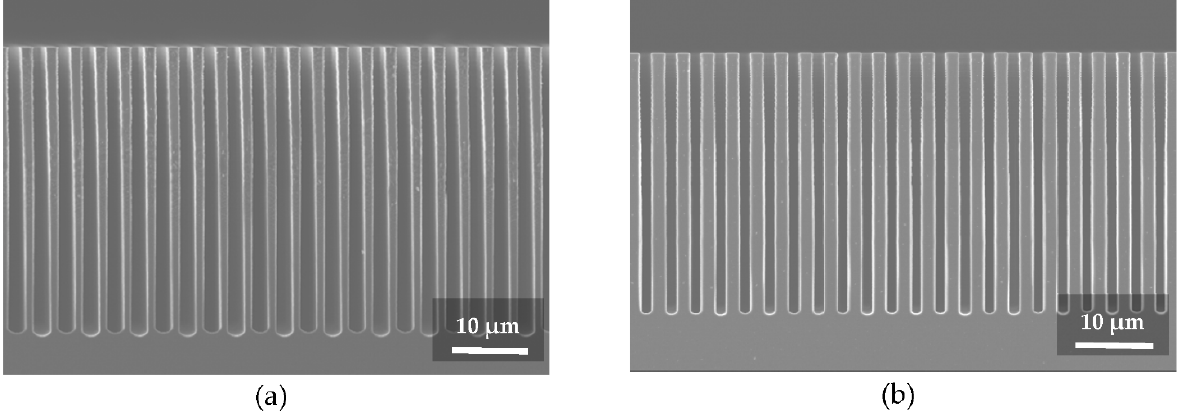
Figure 2. Example of sidewall shape tuning in Si grating with a pitch of 3 µm. Changing the ratio between the times of etching and deposition steps (as shown in Table 1a,b) results in: ( a ) etching with a negative sidewall angle; ( b ) etching with a slight positive sidewall angle, which is suitable for conformal electroplating. Table 1. Etching parameters of grating shown in Figure 2a,b,